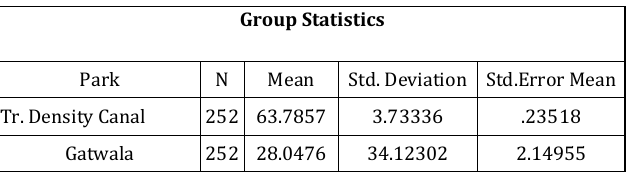
Table 4: Comparison of traffic Density in both sites